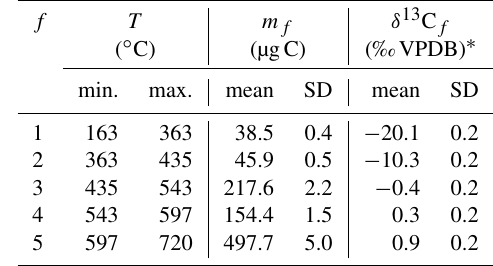
Table 3. JGOFS RPO temperature ranges, carbon masses, and δ 13 C for each fraction, f . All masses and isotope values are blank cor- rected following Hemingway et al.